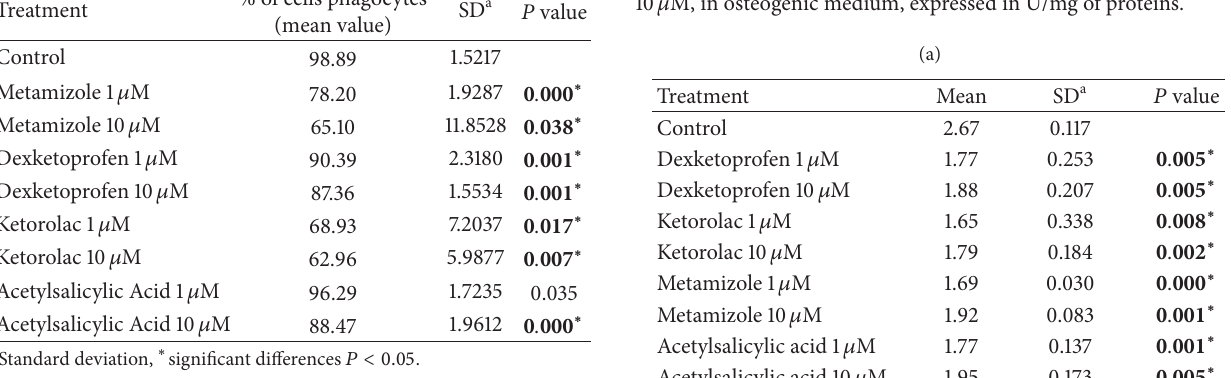
Table 4: (a) ALP activity of MG63-line cell after 24h of treatment with different NSAIDs at doses of 1y 10 𝜇 M, in non-osteogenic medium, expressed in U/mg of proteins. (b) ALP activity of MG63 line cell after 24h treatment with different NSAIDs at doses of 1y 10 𝜇 M, in osteogenic medium, expressed in U/mg of